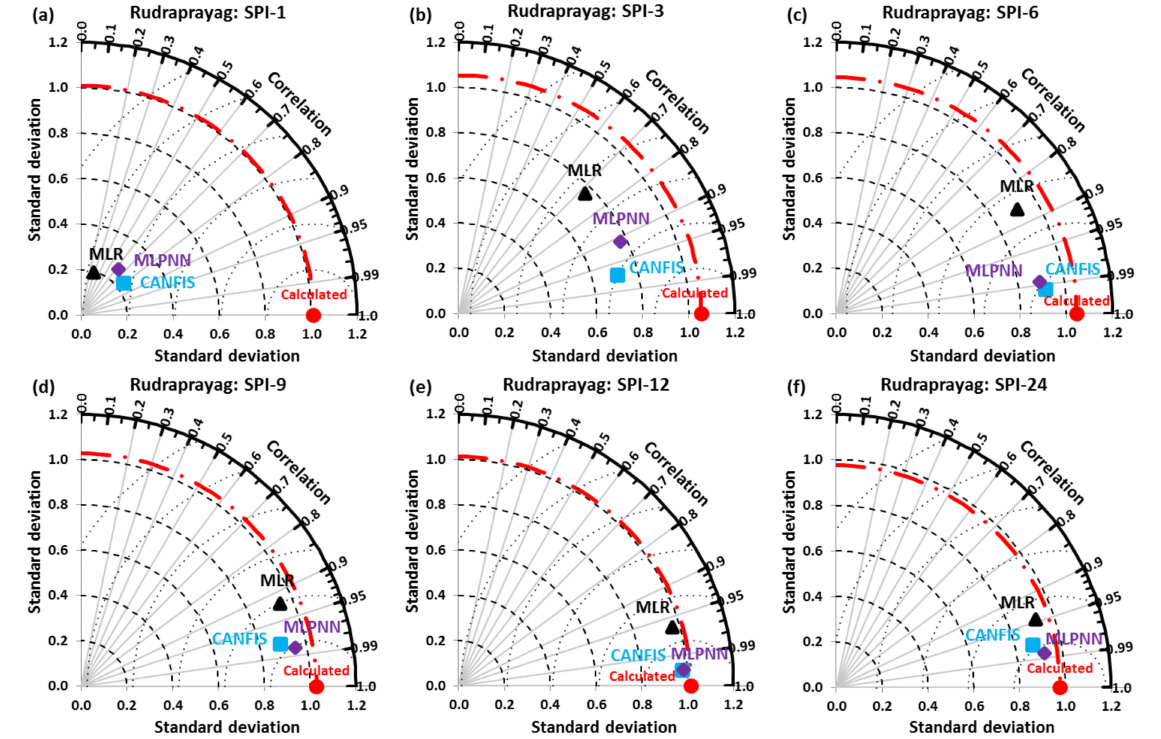
Figure 15. ( a – f ) Taylor diagram of predicted and calculated multi-scalar SPI at Rudraprayag station.